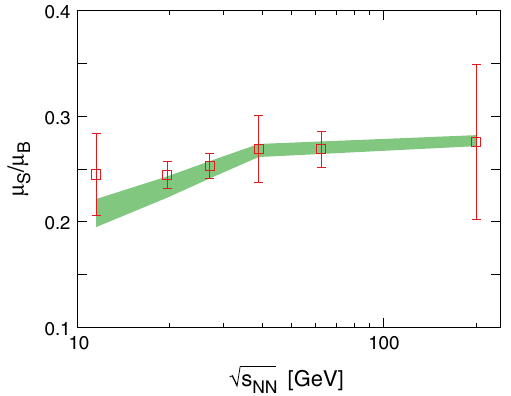
Fig. 3 Ratio μ S /μ B of strangeness over baryon chemical potential as √ s NN (red, open squares) for the freeze-out conditions a function of shown in Fig. 2. The error bars account for the bands in the fits shown in Fig. 1. Using our determined central values for T and μ B we show, in comparison, the corresponding lattice QCD ratio μ S /μ B = s 1 ( T ) + s 3 ( T )μ 2 (colored band), where the bandwidth is deduced from the data B on s 1 ( T ) and s 3 ( T )/ s 1 ( T ) and their errors reported in